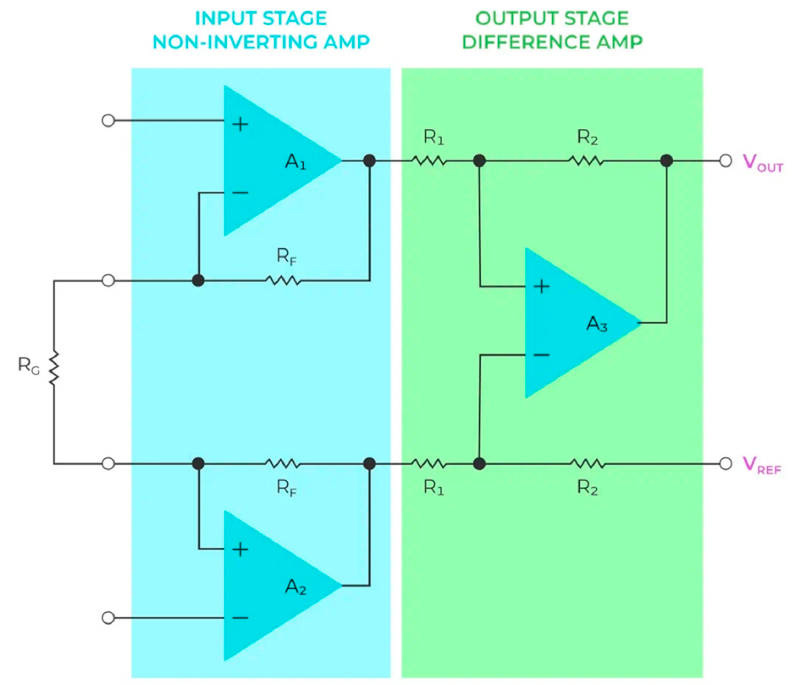
Figure 7. Simplified schematic of monolithic instrumentation amplifier on 3 Op-Amps.